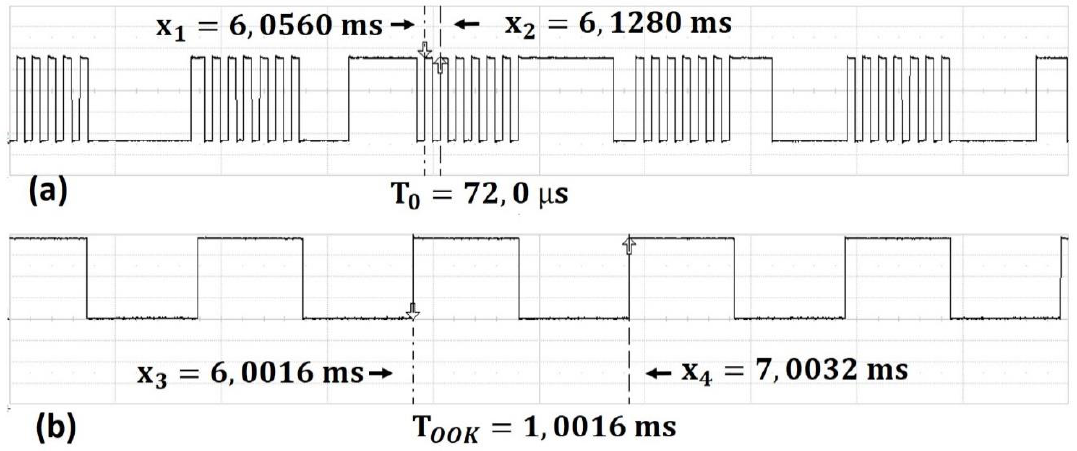
Figure 6. Transmitter with on-off keying (OOK) modulator signal and LTF as receiver signal: ( a ) optical power transmission; ( b ) LTF output frequency.